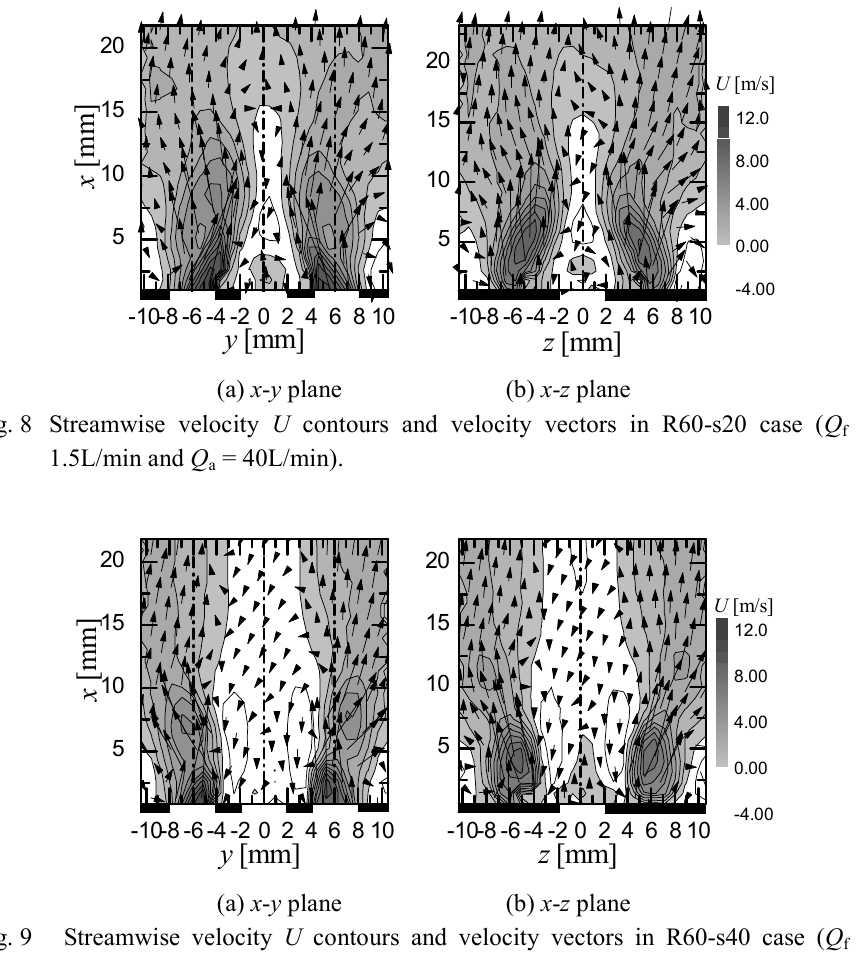
Fig. 9 Streamwise velocity U contours and velocity vectors in R60-s40 case ( Q = 40L/min). 1.5L/min and Q a